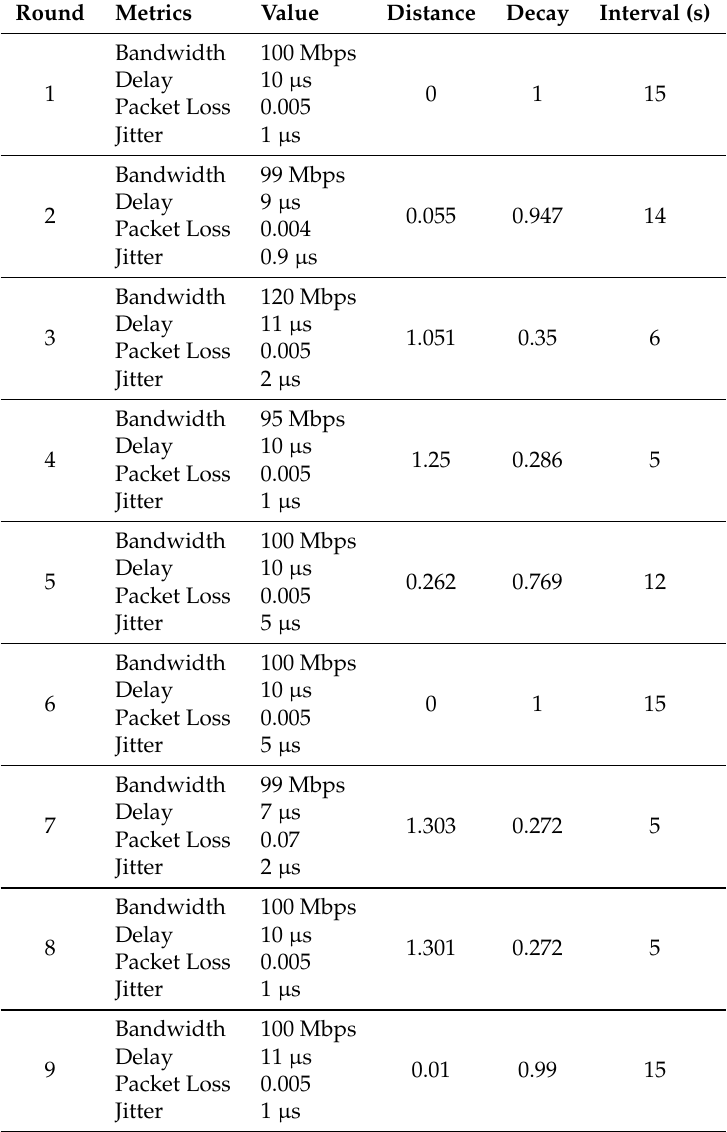
Table 3. An example of adaptive MonLink